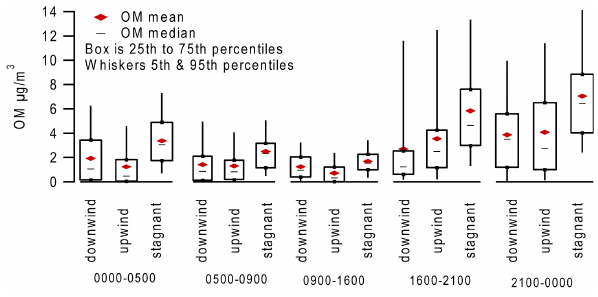
Fig. 4. Box plot of OM concentrations (µgm − 3 ) during downwind, upwind and stagnant (wind speed less than 0.5ms − 1 ) conditions, grouped by time of